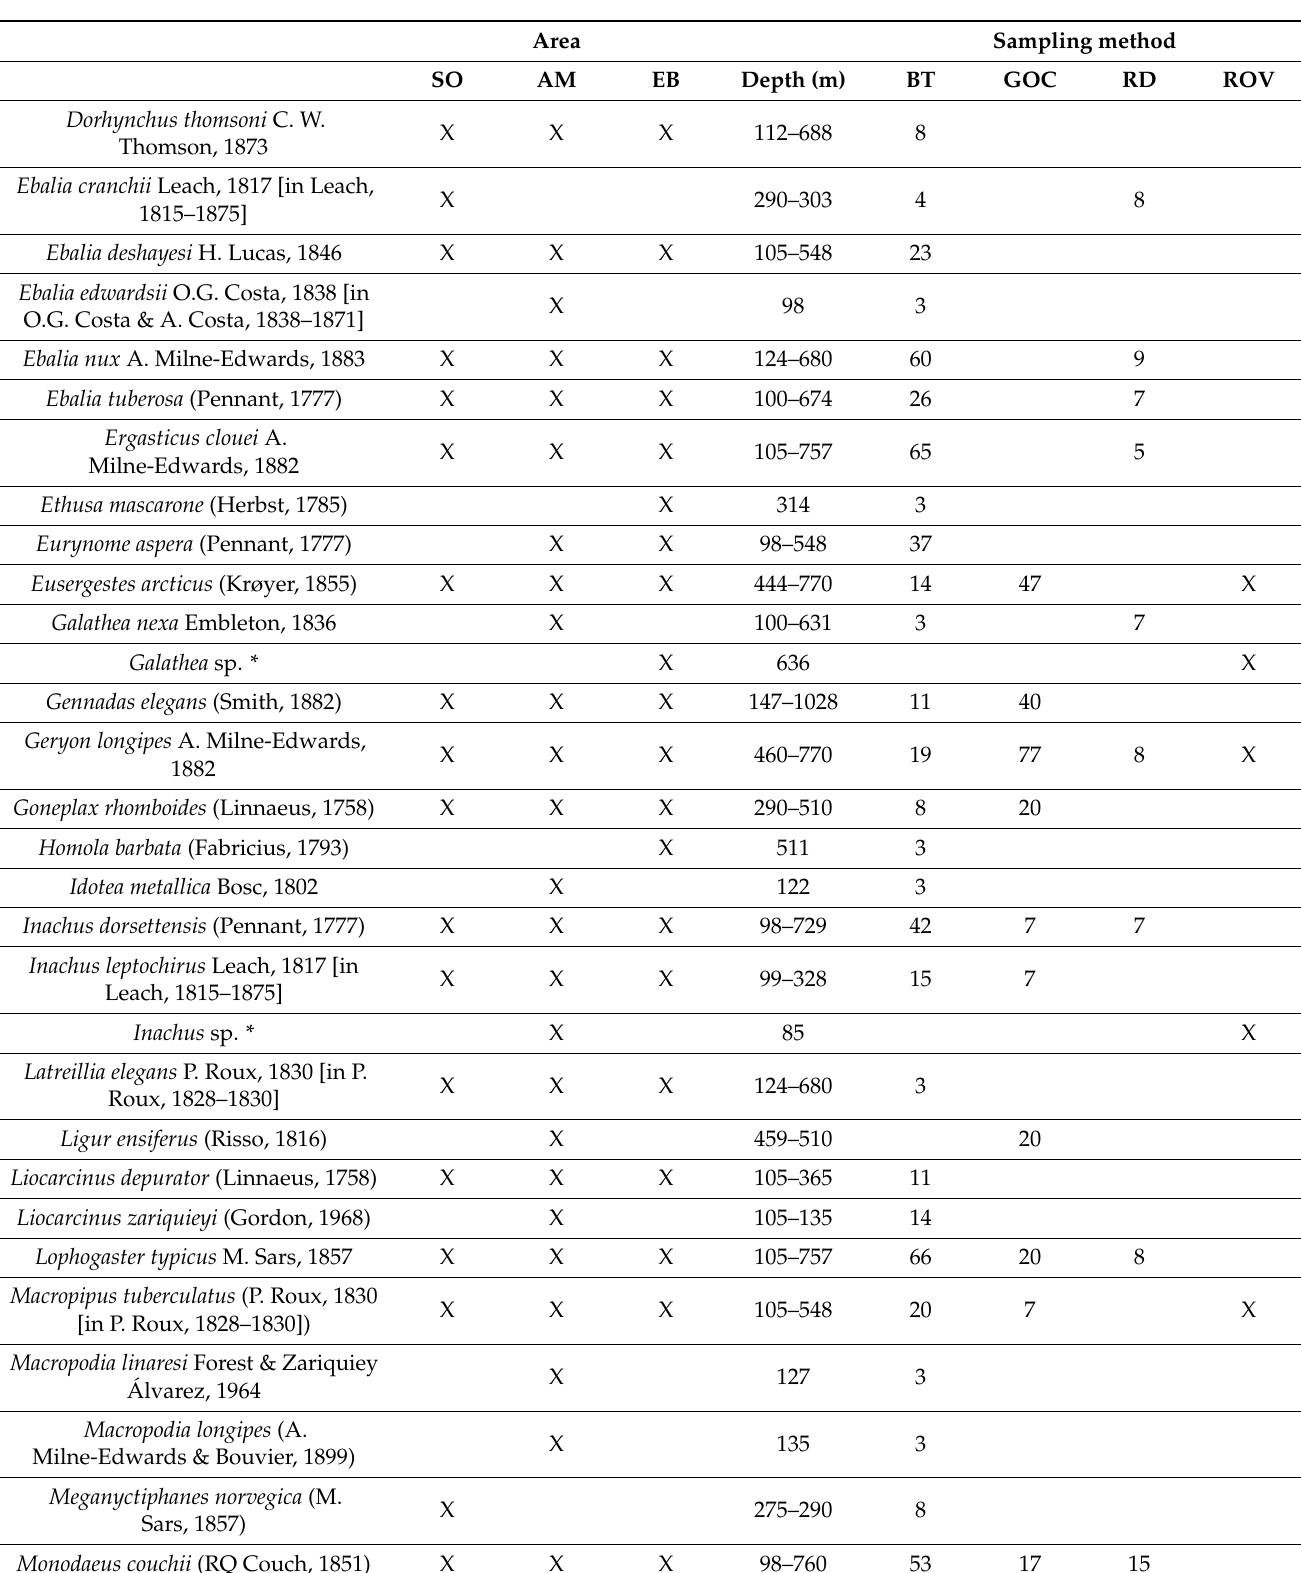
Table A7. Cont. Area Sampling